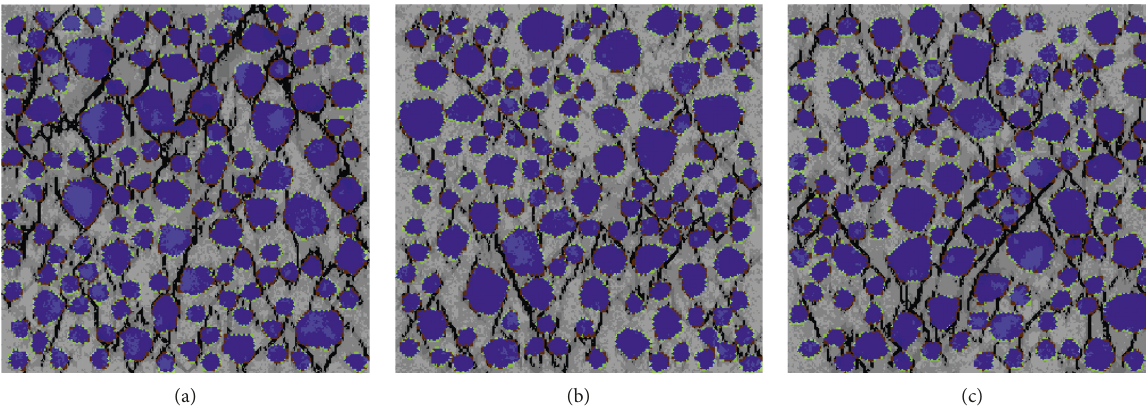
Figure 18: Uniaxial compressive damage process of concrete with different aggregate distributions. (a) Specimen 1. (b) Specimen 2. (c) Specimen 3.